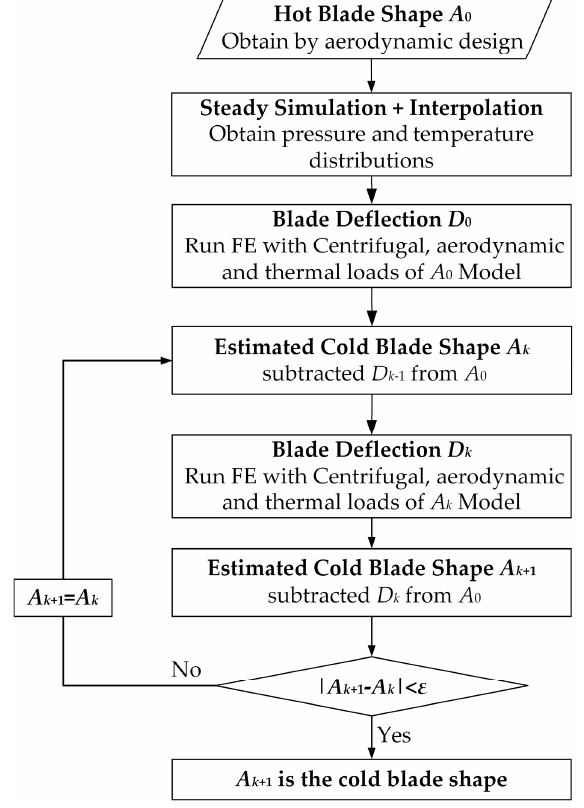
Figure 7. Flow chart of WCS method.